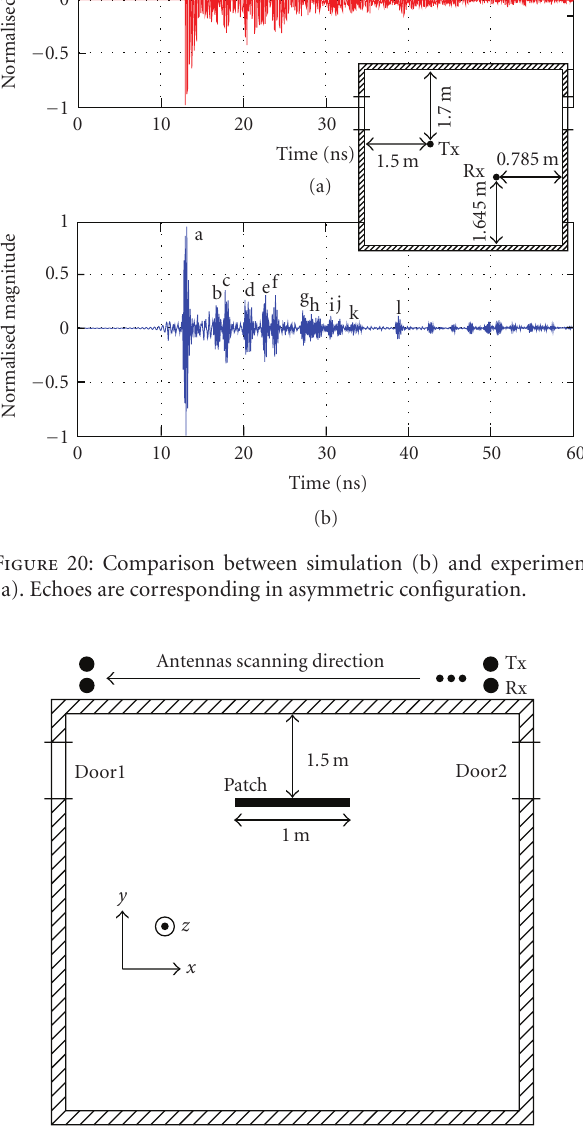
other and attached to the top wall in order to eliminate the waves reflected from it. The considered transceiver is quasi- omnidirectionnal in azimuth plane whereas the receiver is selective and mainly radiates in the direction of the wall. The half power beamwidth of the receiver antenna is equal to 45 ◦